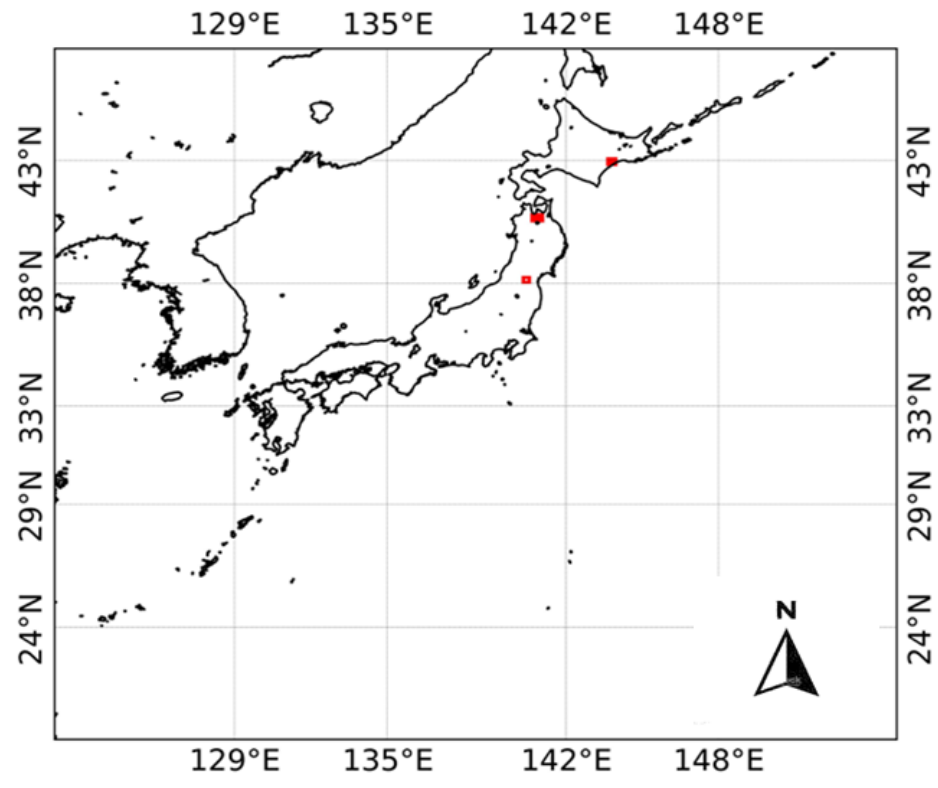
Figure 1. Location map of the study sites: Hakkoda, Zao, and Shiranuka.